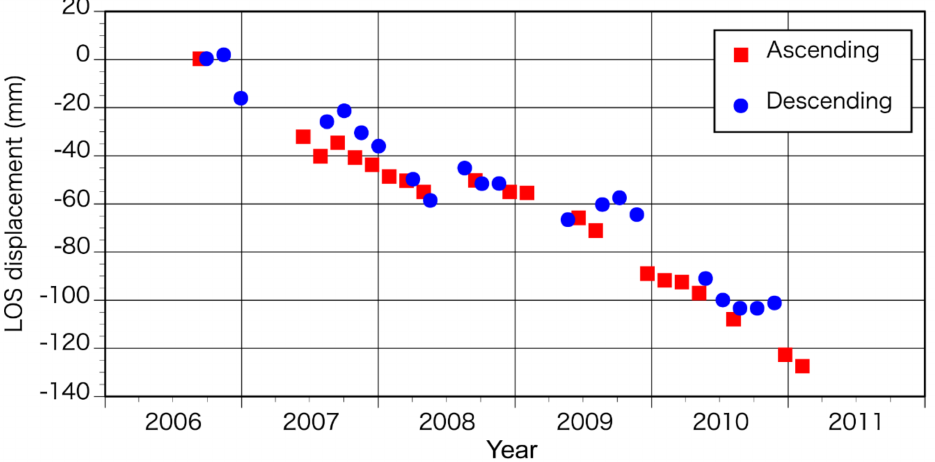
Figure 9. Time variation of displacement in pixels where the maximum velocities were observed to the west of Owakudani. Displacements were obtained by subtracting the displacement of an arbitrarily selected reference point near Sengokuhara (the green points in Figures 5b and 6b) to remove the displacement around the Hakone Volcano.